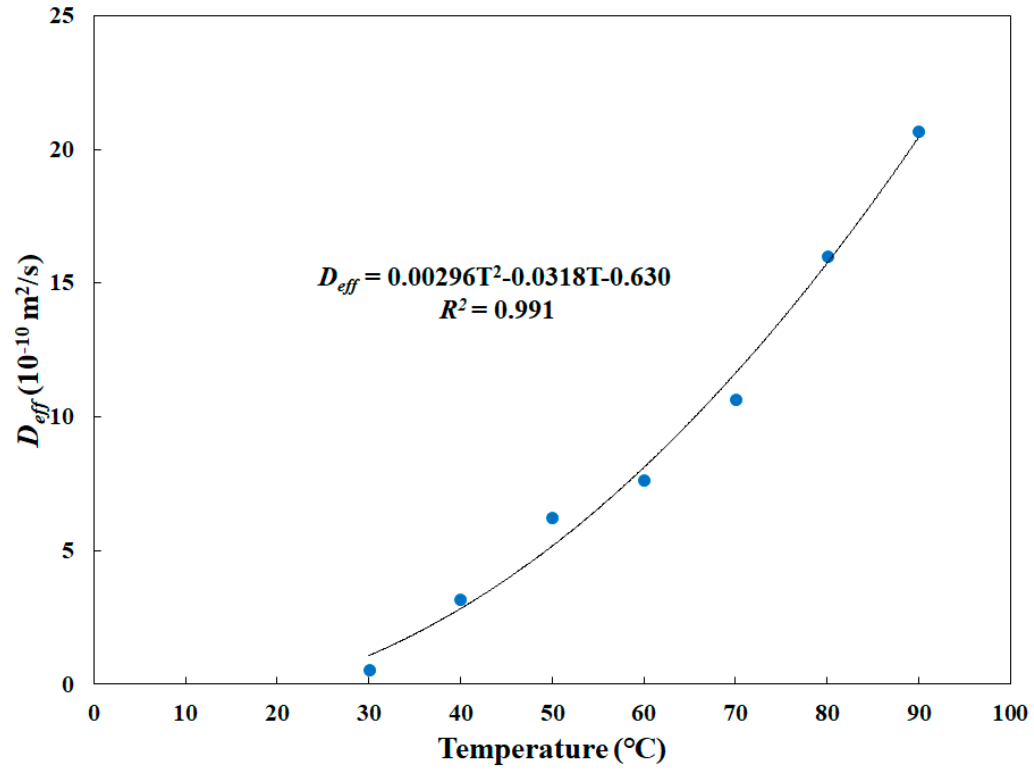
Figure 2. E ff ective moisture di ff usivities of Alaska pollock surimi paste at di ff erent Figure 2. Effective moisture diffusivities of Alaska pollock surimi paste at different temperatures.